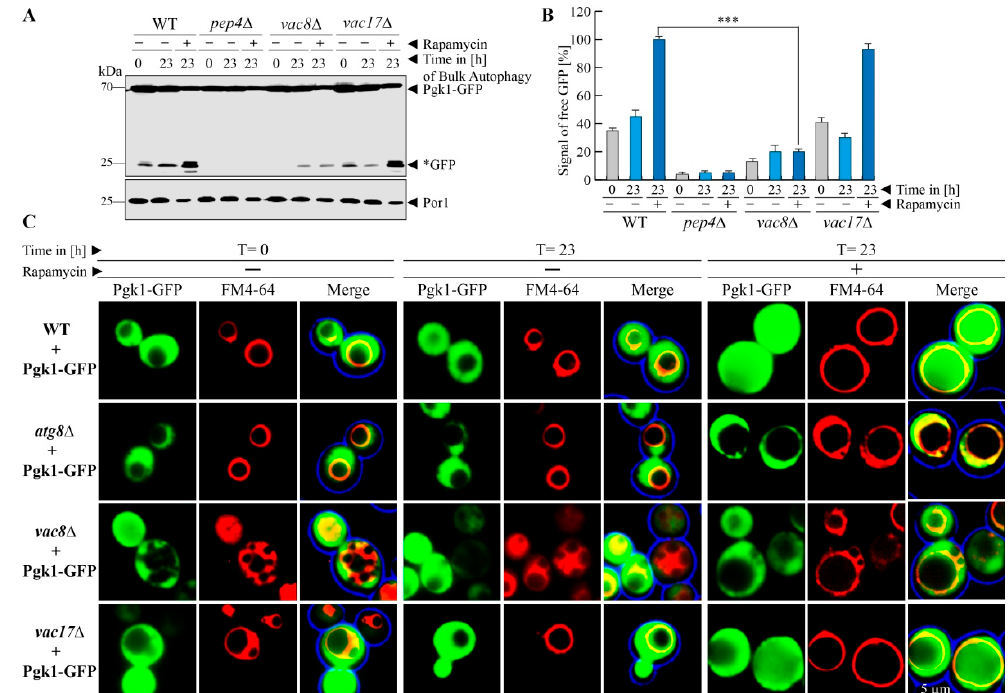
Figure 2. Vac8 is required for efficient bulk autophagy. ( A ) The cytosolic protein Pgk1-GFP shows a certain constitutive turnover. The autophagic degradation of Pgk1-GFP via bulk autophagy was enhanced by the addition of rapamycin. While the Pgk1 portion of the fusion protein is completely degraded in the vacuole, the GFP portion is mostly stable (*GFP). At the end of the bulk autophagy assay (+rapamycin/23 h) a high amount of *GFP was generated in wild-type (WT) and vac17 Δ cells, while the amount of *GFP did not differ from the − rapamycin/23 h sample in vac8 Δ cells. ( B ) This result is supported by statistical analysis of the measured densitometry data of the *GFP signals. The amount of *GFP differs significantly between WT and vac8 Δ cells. *** p < 0.001. ( C ) The localization of Pgk1-GFP during bulk autophagy was analyzed by fluorescence microscopy. At the end of the bulk autophagy assay (+rapamycin/23 h), diffuse GFP signals can be detected within the lumen of the FM4-64-stained vacuolar structures of WT and vac17 Δ cells, while they are devoid of the GFP signal in atg8 Δ and vac8 Δ cells.